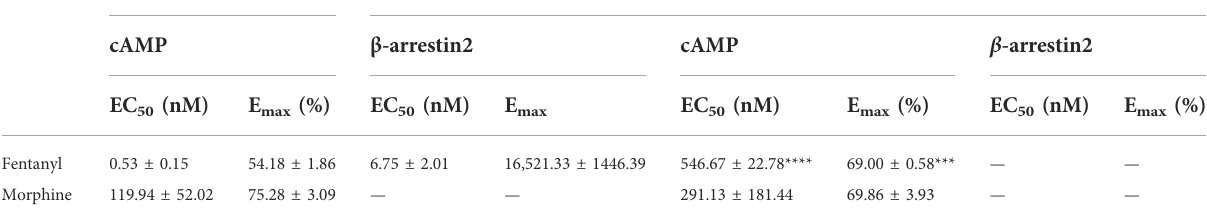
TABLE 2 Activation parameters of test agonists to stimulate µ-opioid receptor – mediated G i/o protein and ß -arrestin signaling pathways Agonist WT Y7.43A cAMP